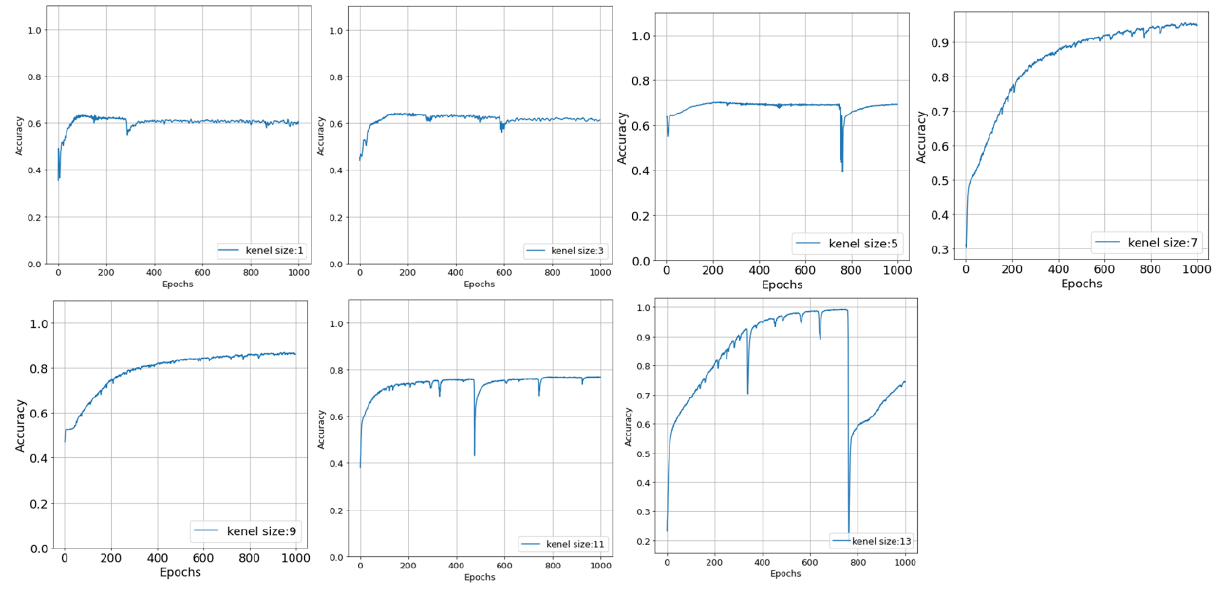
Figure 4. The accuracy curve of DBMF with different kernel sizes. Note: The subfigures are ordered by sizes 1, 3, 5, 7, 9, 11, and 13.